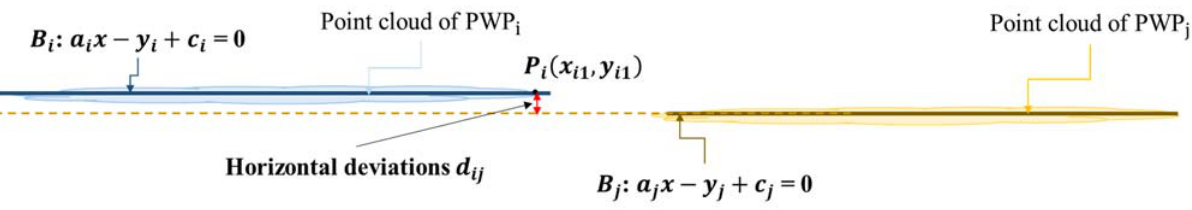
Figure 5. Horizontal alignment deviation computation.